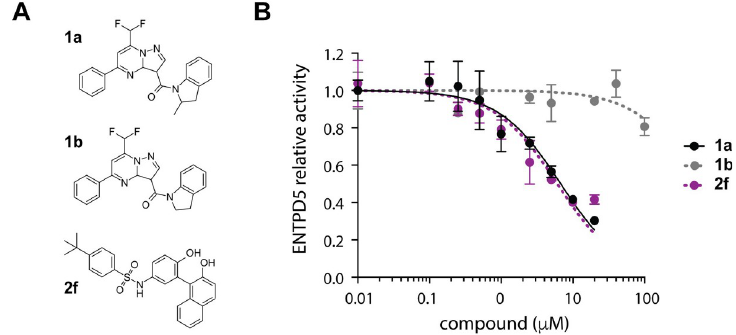
Fig 5. ENTPD5 HTS hit characterization. A) Structures of compounds 1a, 1b, and 2f . B) ENTPD5 inhibition by compounds 1a, 1b, and 2f using the MG assay. 1a IC 50 : 3.1 ± 1.4 μ M; 1b EC 50 > 100 μ M; 2f EC 50 : 1.5 ± 1.3 μ M. Error bars represent standard deviation from triplicate